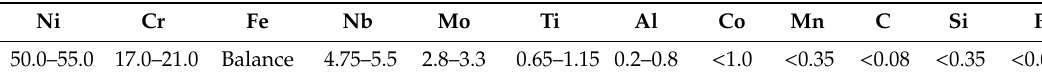
Table 1. The chemical composition of Inconel 718 (wt.%).